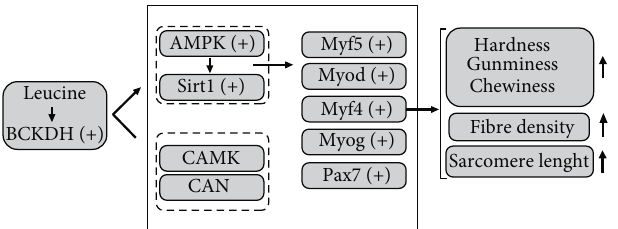
Figure 10: Graphical summary of leucine supplementation increased fl esh quality and muscle growth by activating BCKDH and AMPK in blunt snout bream. “ + ” symbol: expression was upregulated by